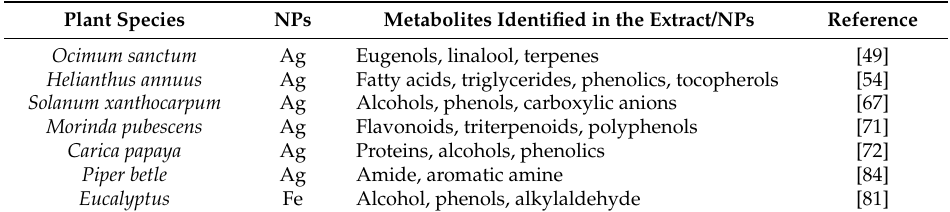
Table 1. Plant components possibly involved in the green synthesis of nanoparticles (NPs) from various plant species.